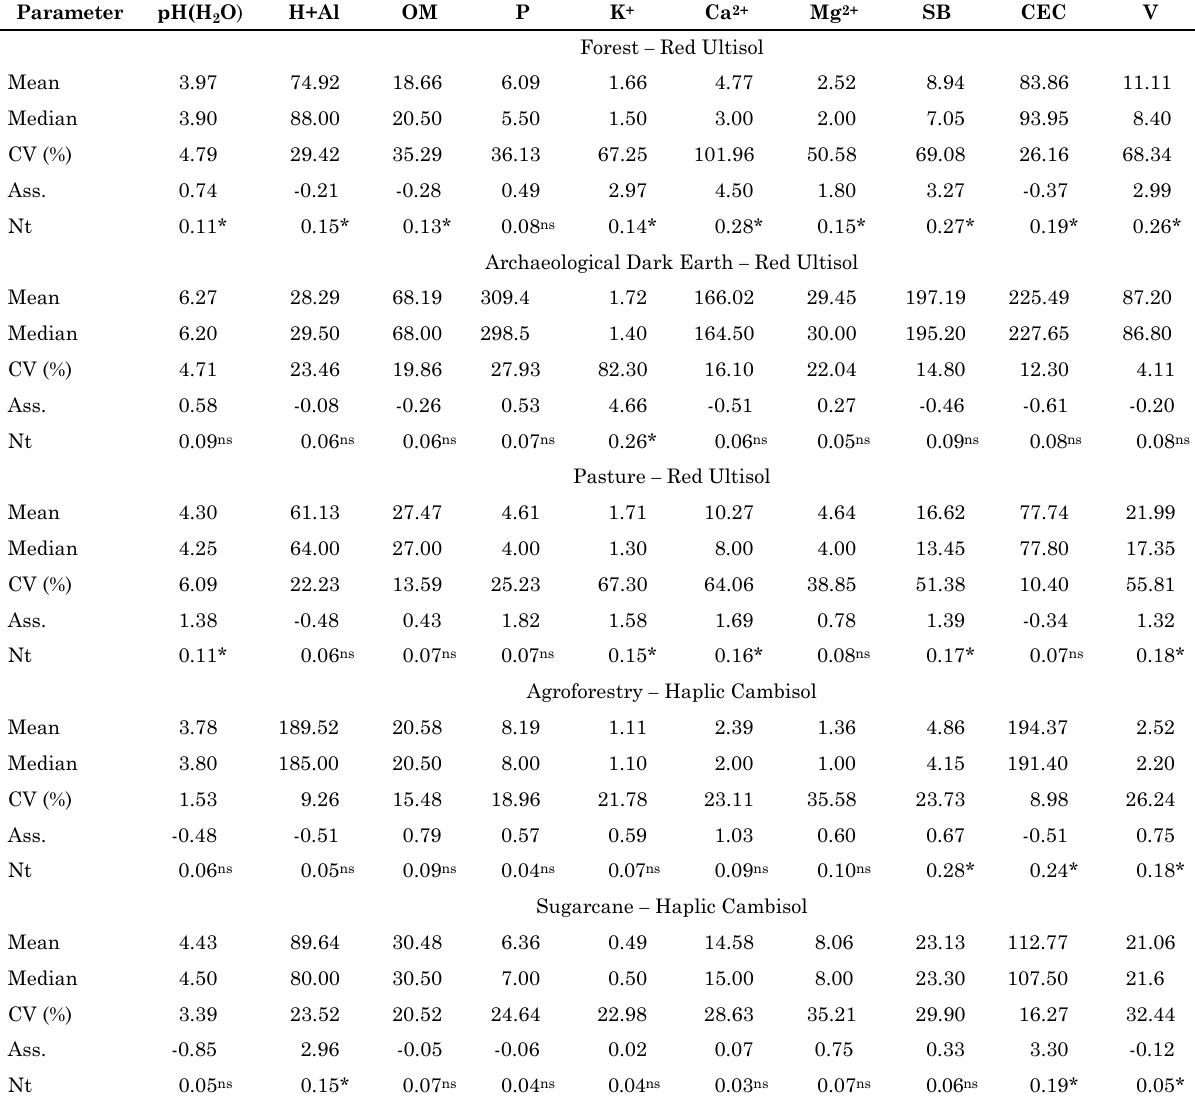
Table 2. Descriptive statistics for soil chemical properties in the municipalities of Humaitá and Manicoré in southern Amazonas Parameter